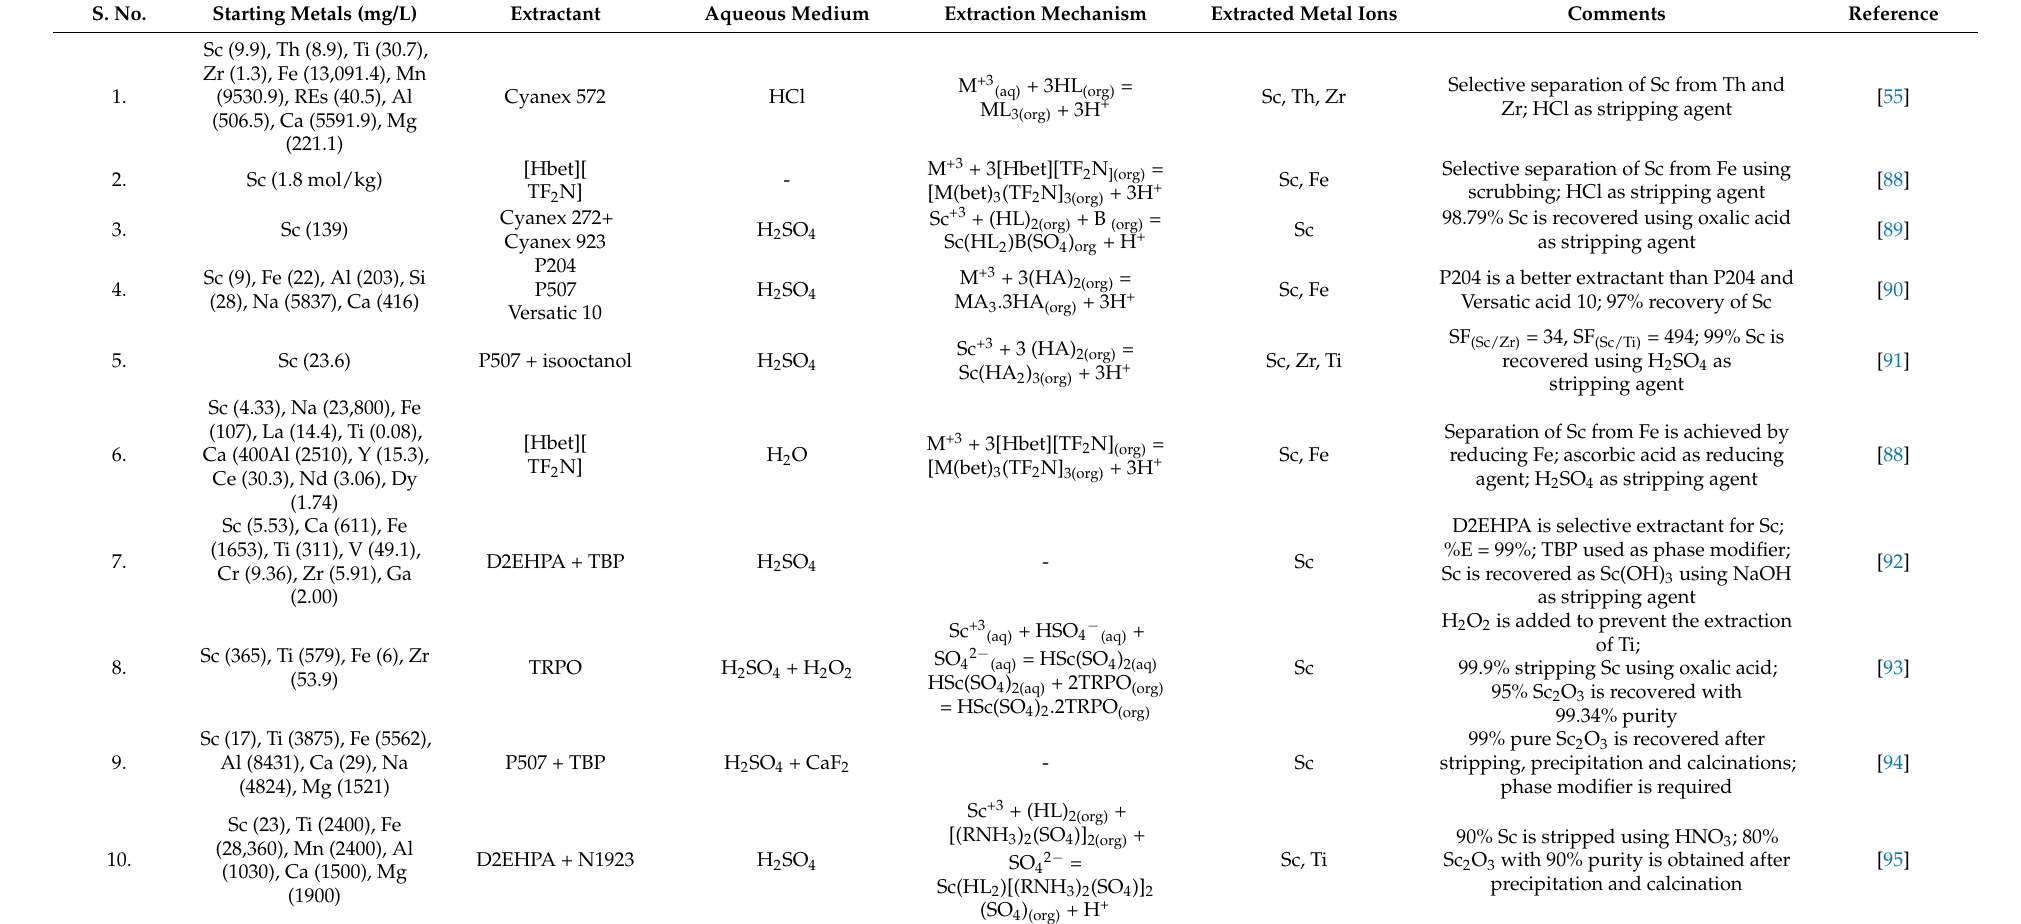
Table 5. Summary sheet on the extraction of scandium using different